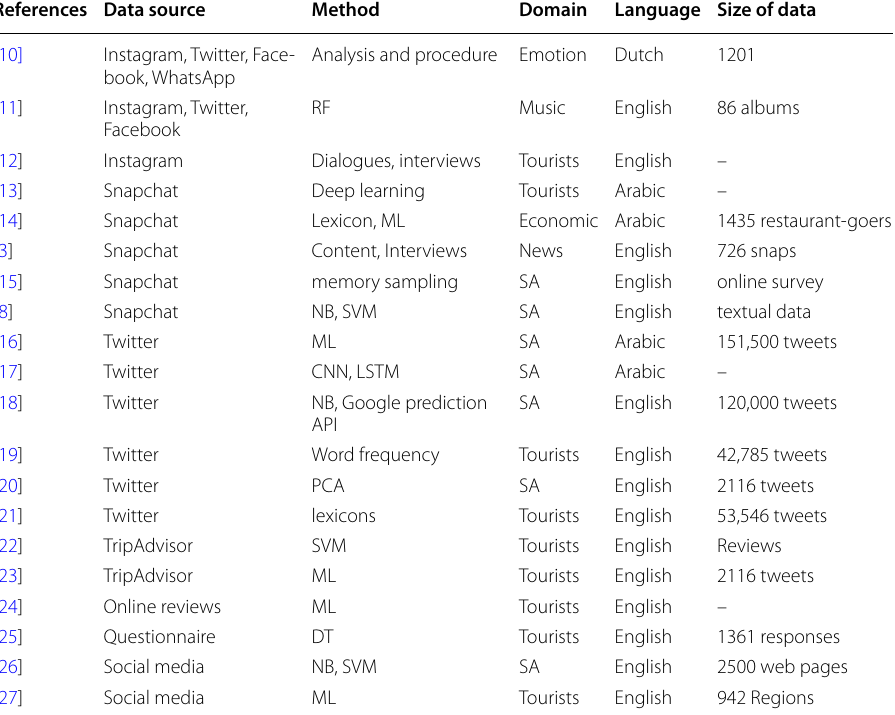
Table 1 Summary of previous studies